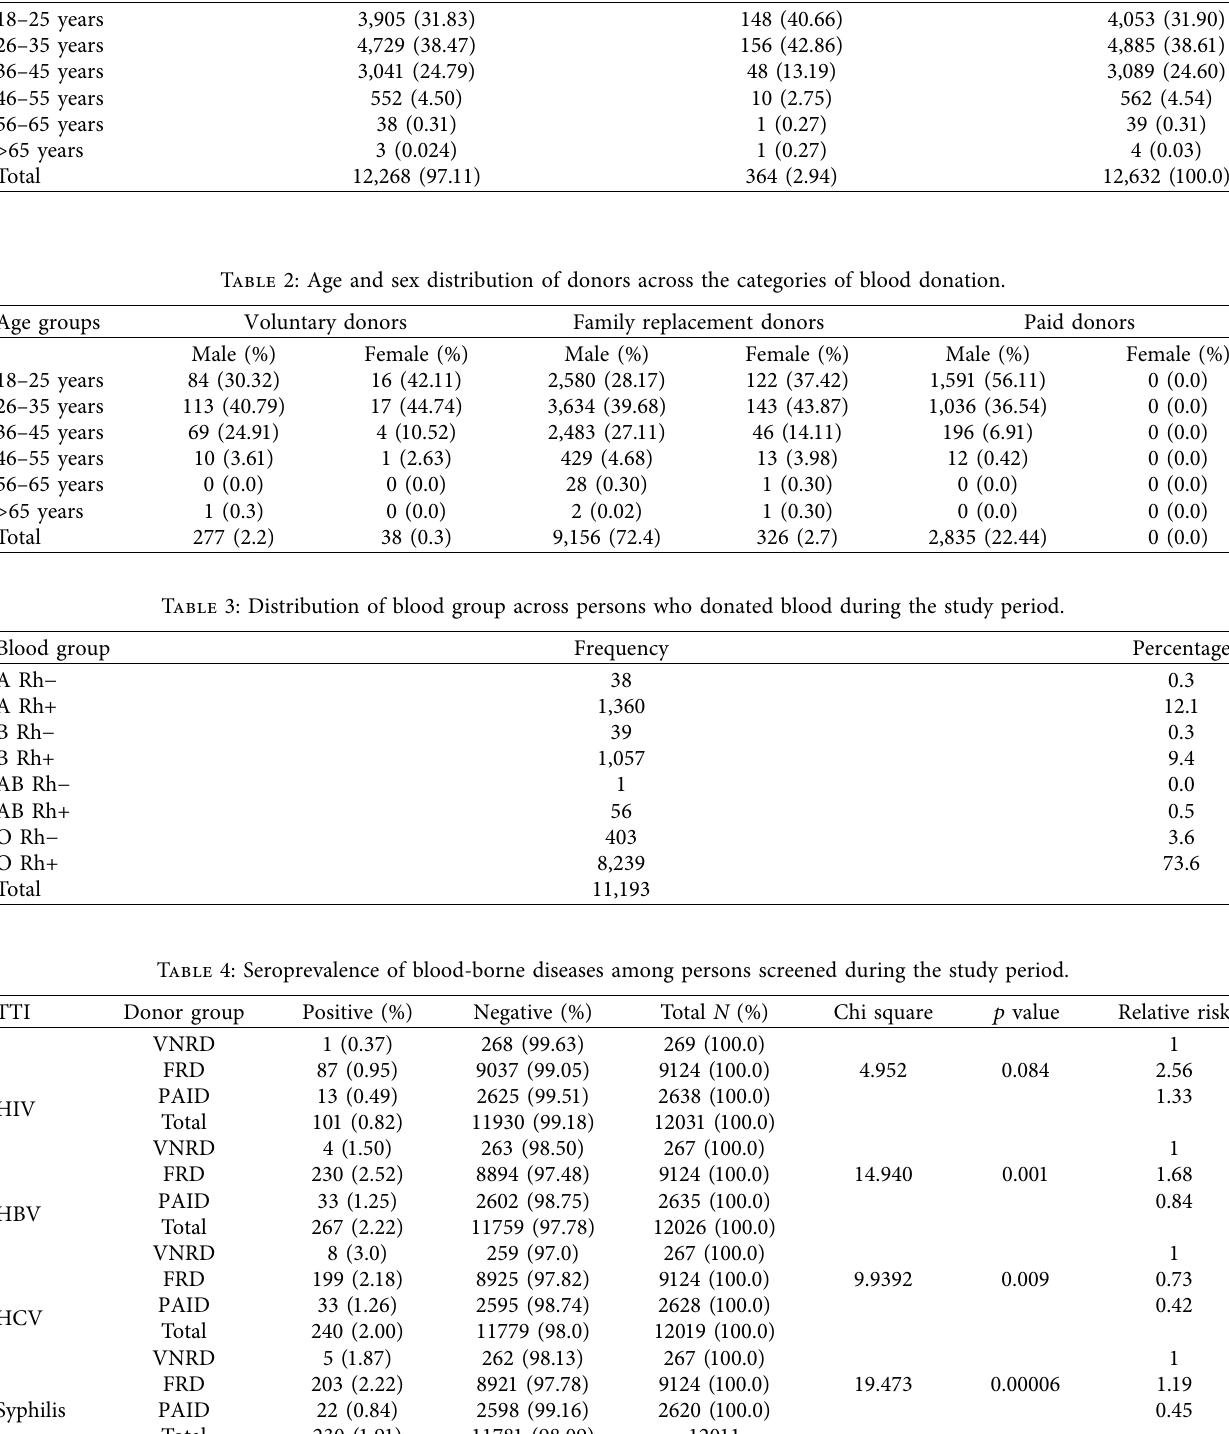
Table 1: Age and sex distribution of persons who donated blood during the study period. Age groups